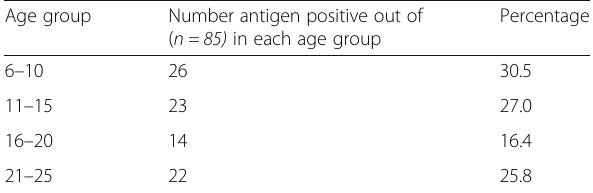
Table 2 Age-wise summary of antigen survey